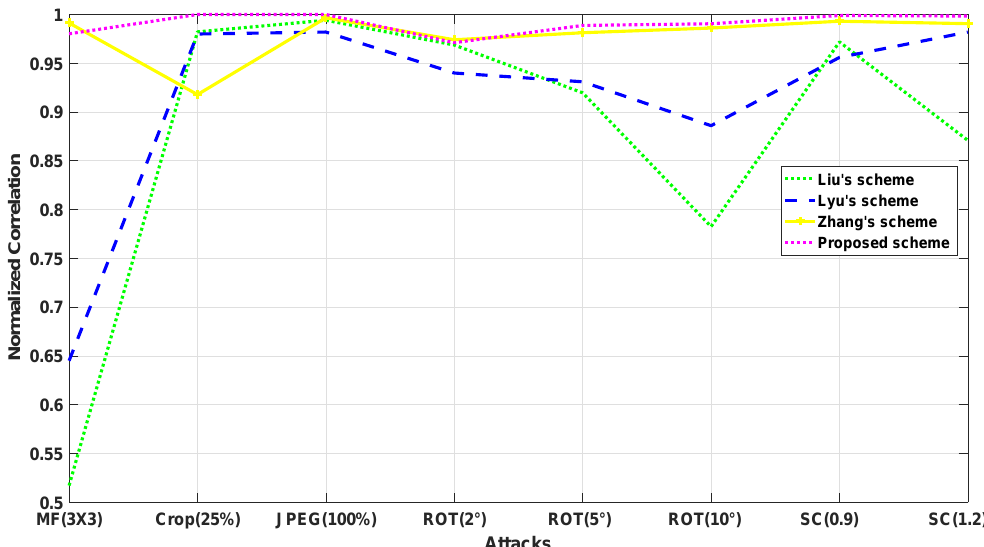
Figure 14. Robustness comparison in terms of NC between Liu et al.’s scheme [21], Lyu et al.’s scheme [29], zhang et al.’s scheme [13] and the proposed